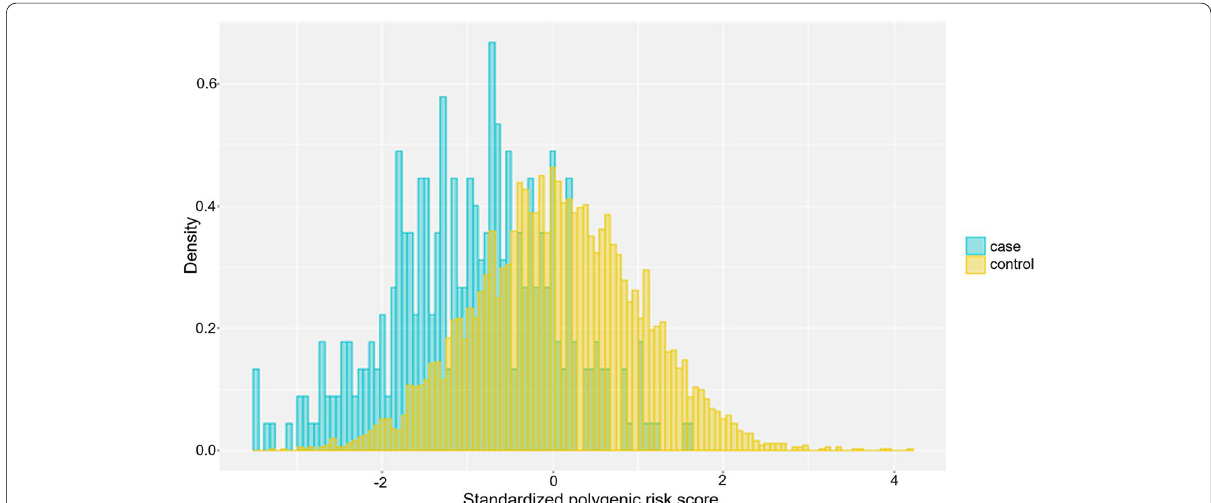
Fig. 3 Genome‑wide polygenic risk score (PRS) for cluster headache. The density distributions of polygenic score for cluster headache in testing dataset. The x‑axis represents polygenic score, with values scaled to a mean of 0 and standard deviation of 1. Cases: blue; Controls: